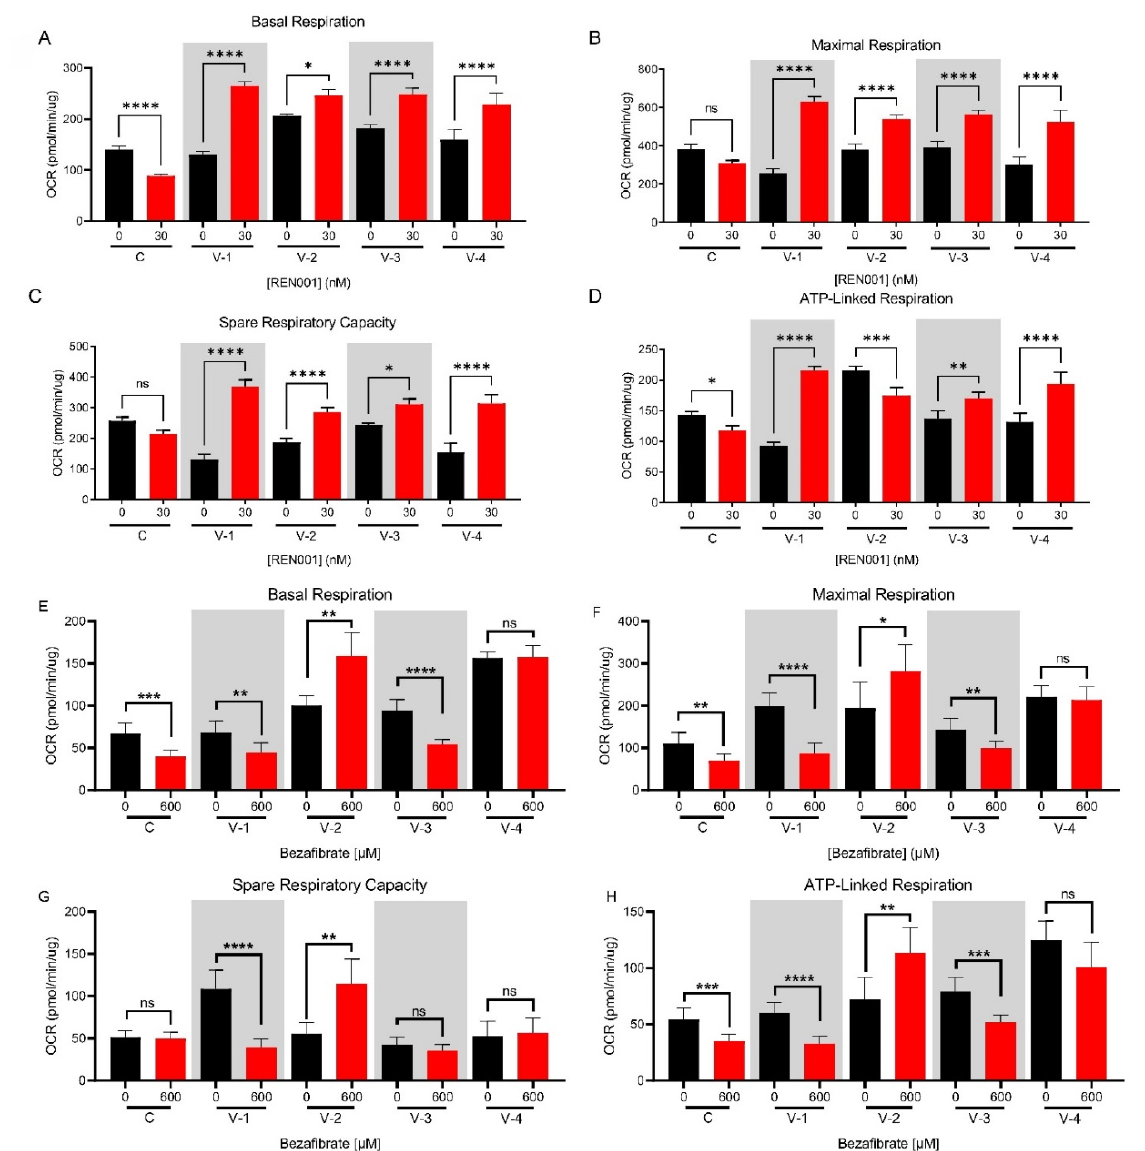
Figure 4. Oxygen consumption rate (OCR) of control and VLCAD-deficient cell lines treated with REN001 for 48 h ( A – D ). Briefly, basal respiration is the OCR of the cells under baseline conditions. Maximal respiration is the OCR measured by exposing the cells to carbonyl cyanide-4 (trifluoro- methoxy) phenylhydrazone (FCCP), which is an uncoupling reagent that collapses the proton gradient and disrupts mitochondrial potential. Electron flow through the electron transport chain is disrupted and complex IV reaches the maximum OCR. Spare respiratory capacity is the cell’s ability to respond to stress via exposure to rotenone and antimycin (ROT/AA; complex I and II inhibitors, respectively). ATP production is the decrease in OCR via exposure to ATP synthase inhibitor (complex V), oligomycin, and represents the portion of basal respiration used to drive ATP production. Basal respiration ( A ), maximal respiration ( B ), spare respiratory capacity ( C ), and ATP production ( D ). Oxygen consumption rate of control and VLCAD-deficient cell lines treated with bezafibrate (BEZ) for 48 h ( E – H ). Basal respiration ( E ), maximal respiration ( F ), spare respiratory capacity ( G ), and ATP production ( H ). Bars represent mean and standard deviations in duplicate assays. * p < 0.05, ** p < 0.01, *** p <0.001, **** p < 0.0001, ns = no significant, compared to each cell line’s own 0 nM treatment (n = 6 for all assays; t -test for unpaired